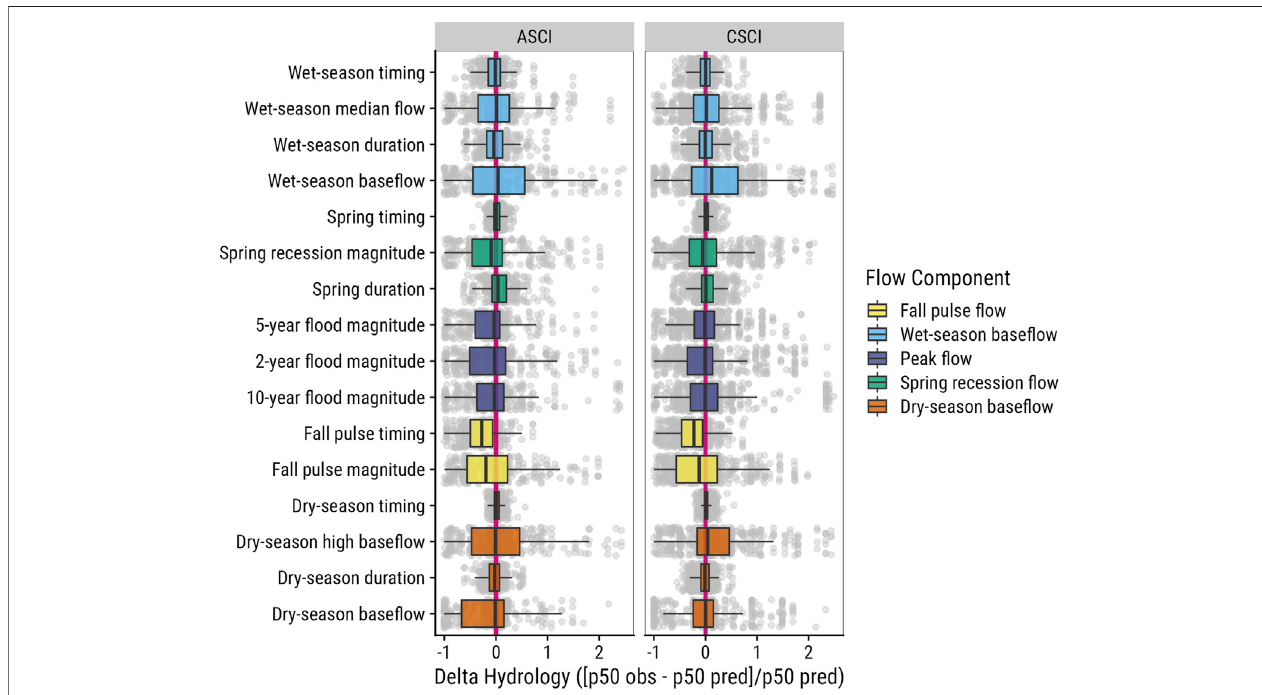
FIGURE 4 | Boxplots of delta hydrology for functional fl ow metrics used in the modeling analysis for paired sites across California. The solid pink line in the background indicates no difference between the observed 50th percentile and the predicted reference 50th percentile metric value. Values to the left of the line are reduced or early, and values to the right are in fl ated or late, relative to the expected reference value. Extreme outliers ( > 98 percentile) have been removed from the boxplot.